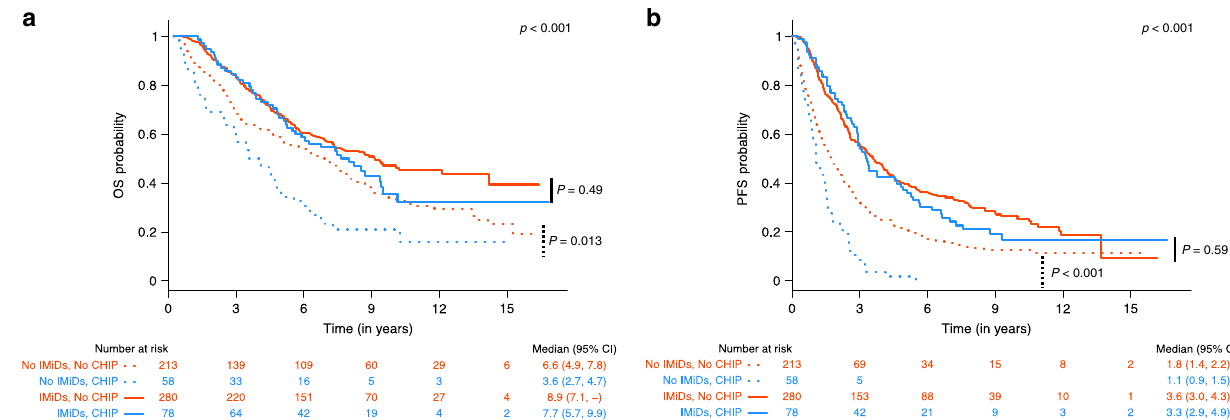
Fig. 4 Overall survival and progression free survival of patients with respect to IMiD maintenance and CHIP. a OS and b PFS among patients with CHIP versus those without CHIP in the context of receiving versus not receiving IMiD maintenance post ASCT. Overall and pairwise two-sided log-rank p -values are shown unadjusted for multiple